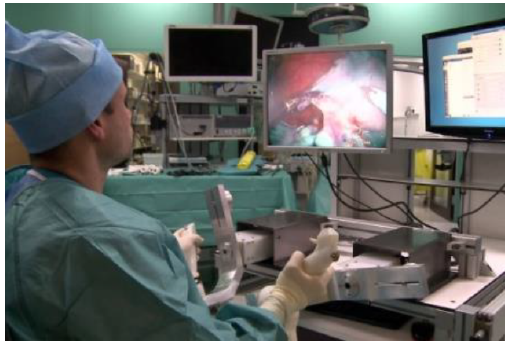
Figure 2. STRAS endoscope manipulation.